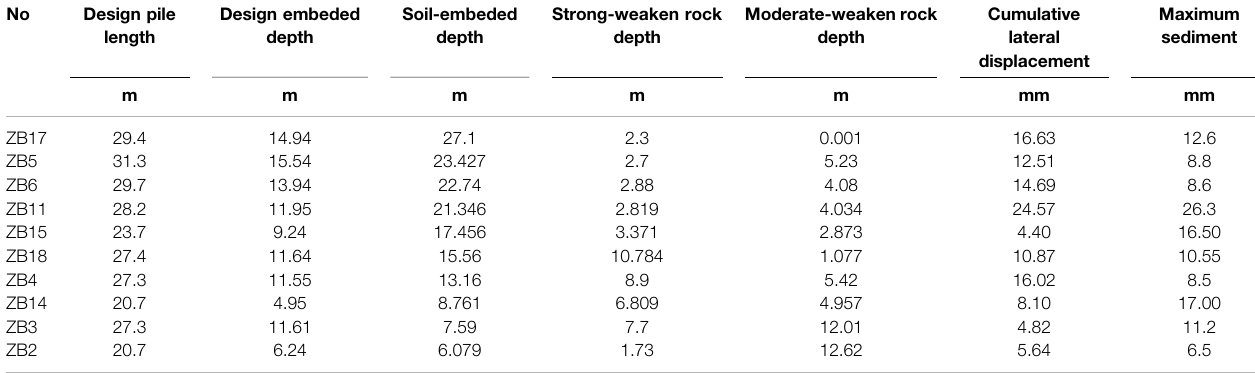
TABLE 2 | Displacement and settlement value of foundation pit retaining